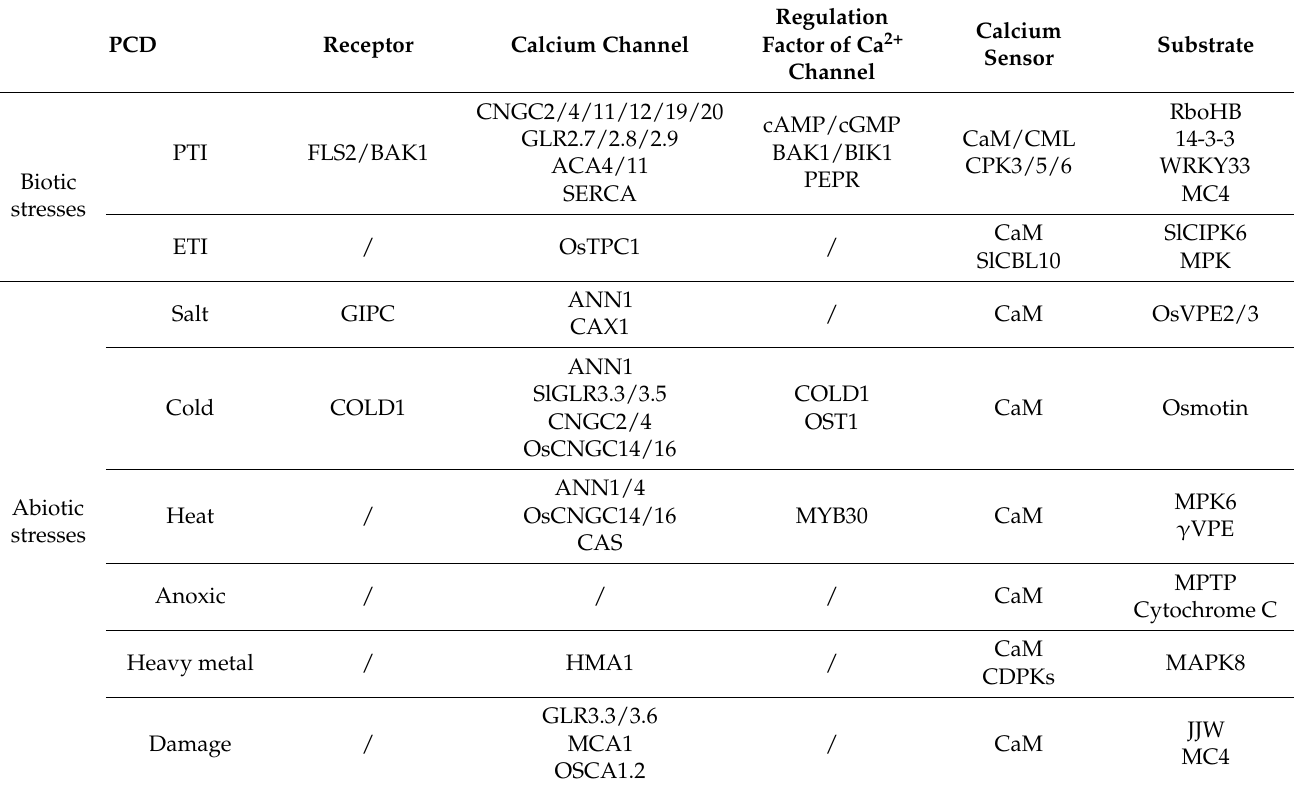
Table 1. The regulation factors of the calcium signal in plant PCD under biotic and abiotic